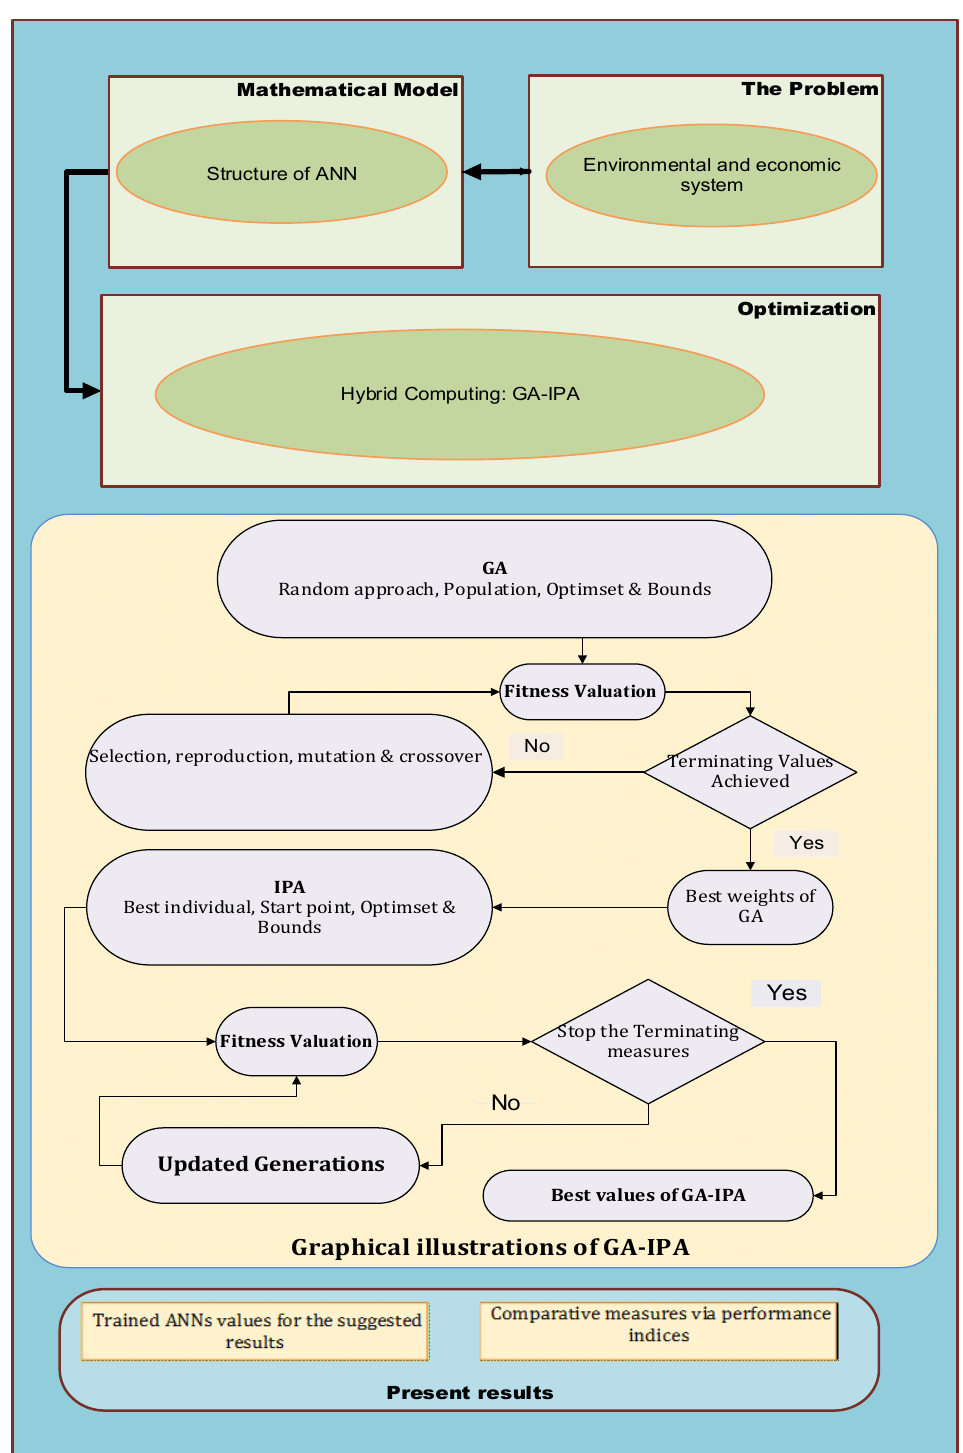
Figure 1. Design procedure of ANN-GA-IPA to solve the nonlinear environmental and economic model.